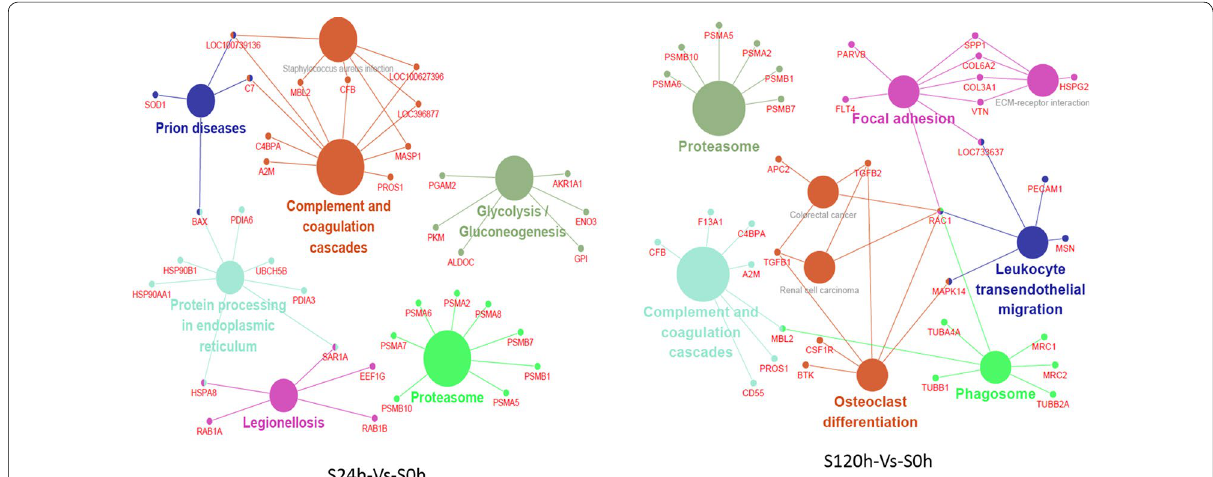
Fig. 6 The related DEPs and pathways. Left: at “S24-Vs-S0” stage. Right: at “S120-Vs-S0” stage. The nodes represent that had cross-talk between each other